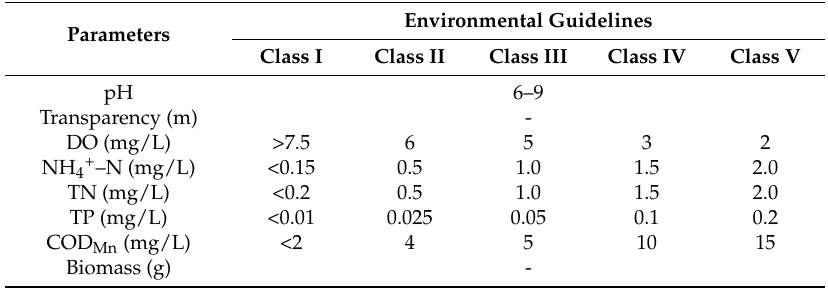
Table A1. The environmental guidelines (GB3838-2002) of water quality for Honghu